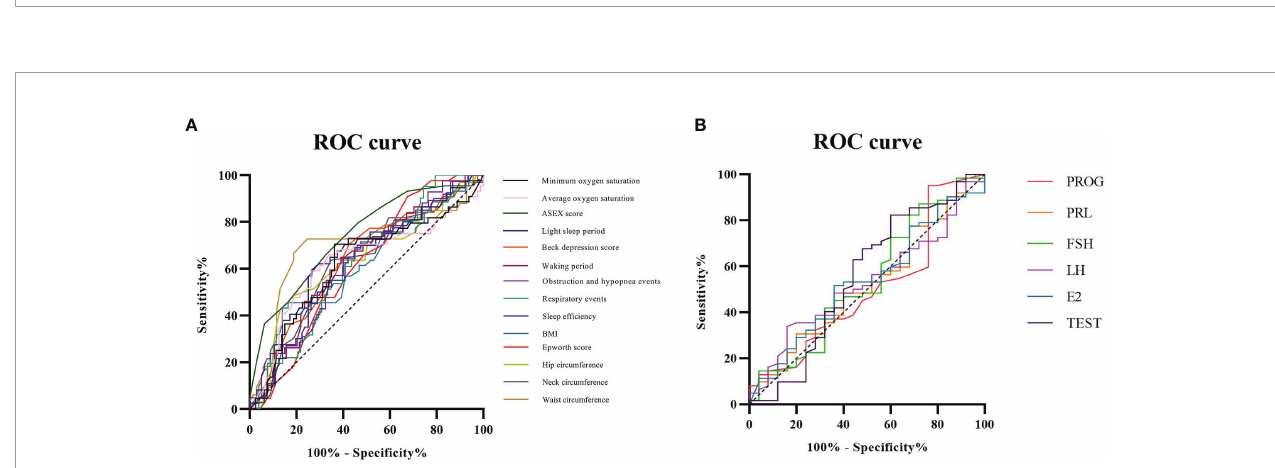
FIGURE 5 | ROC curve analysis of related factors in OSA patients. (A) Compared with the IIEF-5 scoring standard, ASEX score and waist circumference had general diagnostic value, and the 12 related factors had low diagnostic value; (B) Compared with that of the IIEF-5 scoring standard, the diagnostic value of the six related factors was